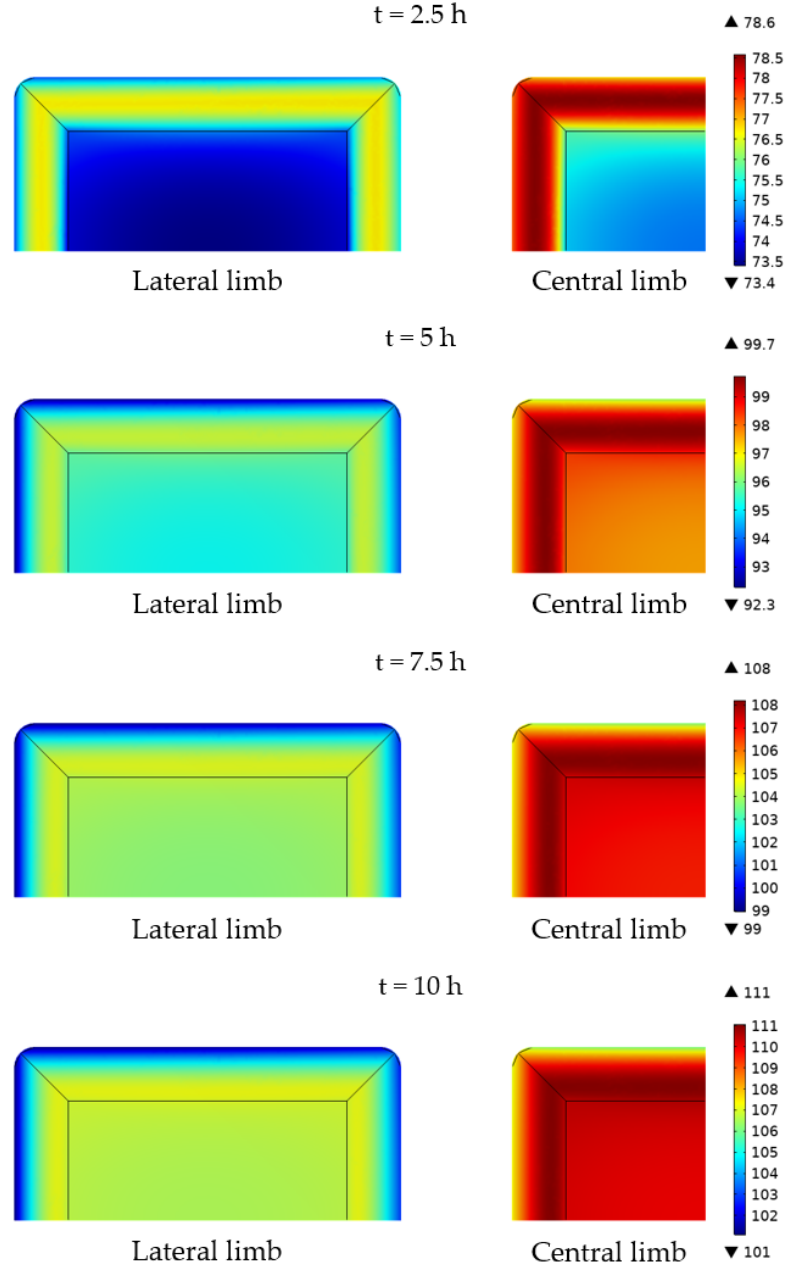
Figure 11. Temperature distribution, in °C, in a horizontal slice in the central section of the core and the windings for different time instants. Case 6. Considering the detailed comparison of the transformer temperature distribution and evolution, both under steady-state and transient conditions, the predictions of the simple numerical model proposed, considering non-isotropic thermal conductivities for the core and windings, were found to be in excellent agreement with the experimental measurements conducted in the prototype. Therefore, the numerical model presented here was properly validated and can be used as a powerful tool to estimate the time evolution of temperature and its distribution in similar transformers with a very reduced computational